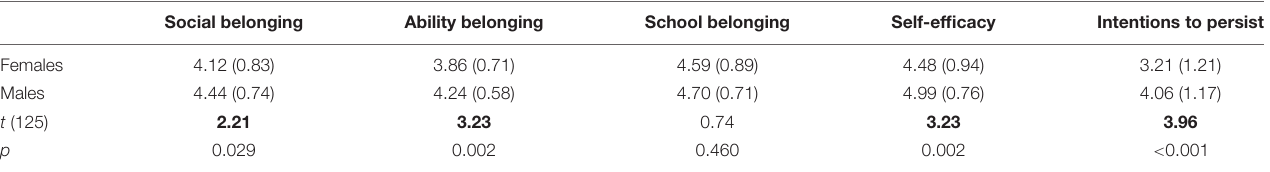
TABLE 1 | Gender differences in belonging, efficacy, and intentions to persist in pSTEM. Social belonging Ability belonging School belonging